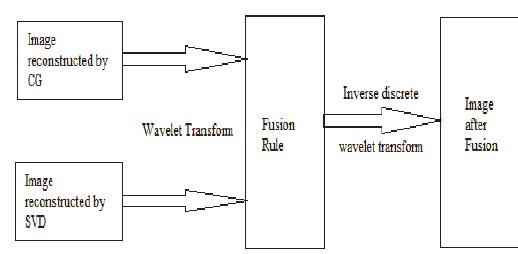
Fig. 11: Wavelet image fusion algorithm redrawn from [52].